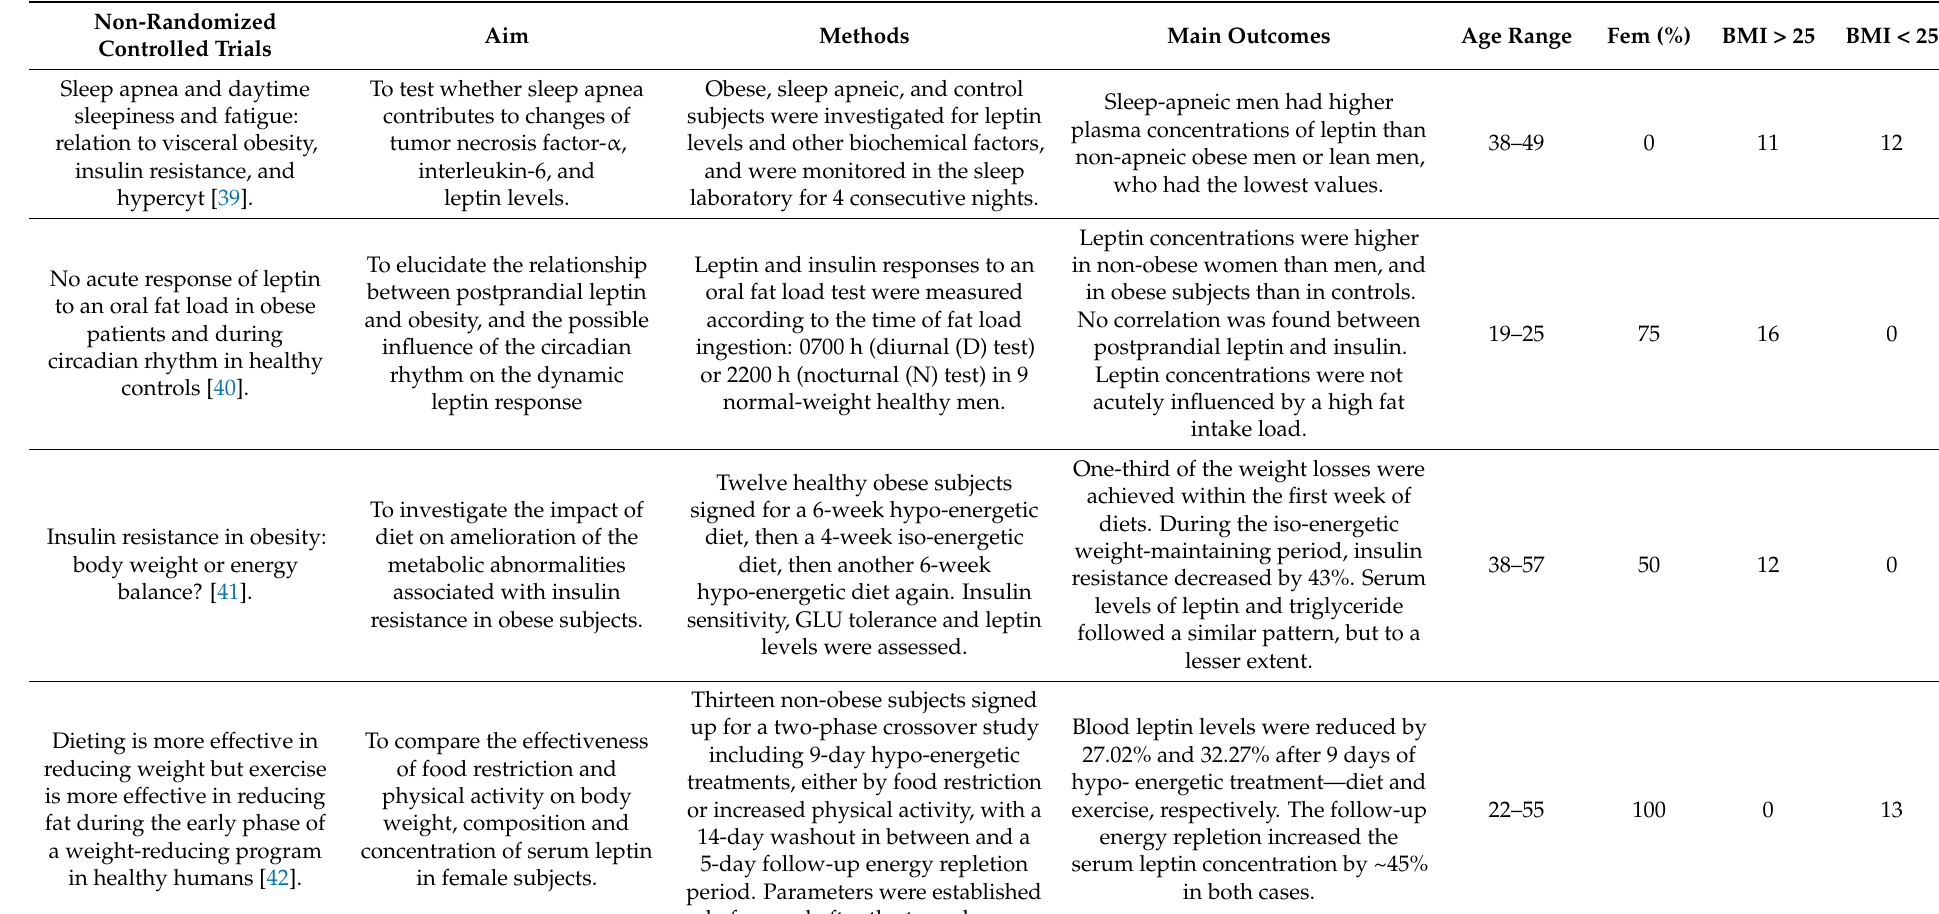
Table 1. Summary of non-randomized controlled studies’